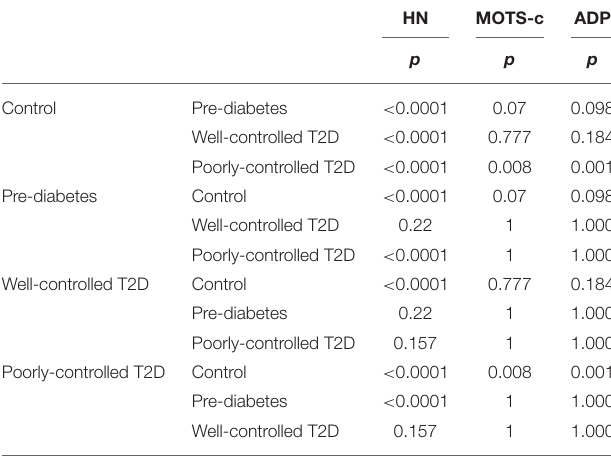
Table shows post-hoc analysis comparing HN, MOTS-c, and ADP between control, prediabetes, well-controlled T2D and in poorly-controlled T2D subjects.